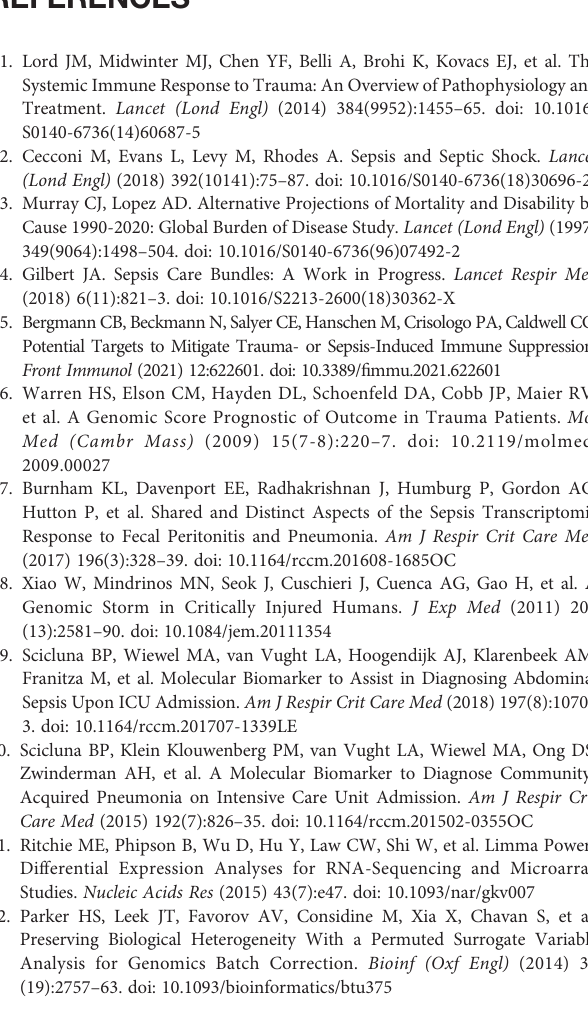
number of downregulated and upregulated DEGs. FC, fold change; FDR, false discovery rate; DEGs, differentially expressed genes. Supplementary Figure 2 | Identi fi cation of modules related to clinical traits in trauma and sepsis by WGCNA. (A) Sample clustering to detect outliers, excluding GSM1602973 ofthe sepsis cohort. (B) Analysis of the scale-free fi t index for various soft-threshold powers. (C) Analysis of the mean connectivity for various soft- threshold powers. (D) Clustering of module eigengenes. Modules whose distance were less than 0.25 (red line) were merged. (E) Cluster dendrogram of co- expression network modules ordered by a hierarchical clustering of genes and based on the 1-TOM matrix. Different colors represent different modules. (F) Module – trait relationships. Each row represents a color module, and each column represents a clinical trait (normal and tumor). Each cell contains the corresponding correlation and P-value. (G) MM versus GS plots of the key modules. ME, module eigengenes; MM, module membership; GS, gene signi fi cance. Supplementary Figure 3 | Identi fi cation of common genes and biological functions shared by trauma and sepsis. (A) The Venn diagram of genes among the two DEG lists and the two lists of co-expressed genes. A total of 144 overlapping differentially co-expressed genes were detected (124 genes upregulated and 20 genes downregulated). (B) Enrichment analysis of the identi fi ed common genes. Supplementary Figure 4 | Immune cell fractions in trauma and sepsis